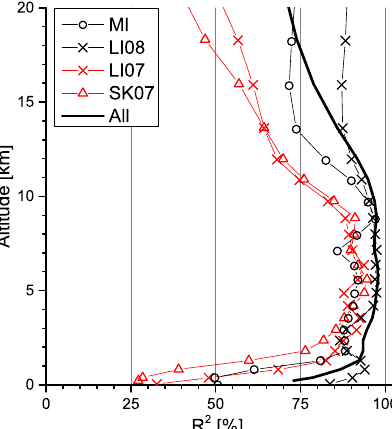
Figure 15. Profiles of correlation coefficients ( R 2 ) for comparison between GRUAN and MUSICA IASI (for retrievals that use the GRUAN temperature profiles as the a priori atmospheric tempera- tures). Different line colours and symbols show the different ensem- bles and thick black solid line for considering all four ensembles as a single data set (the R 2 values for the latter are also written in the panels of Fig.